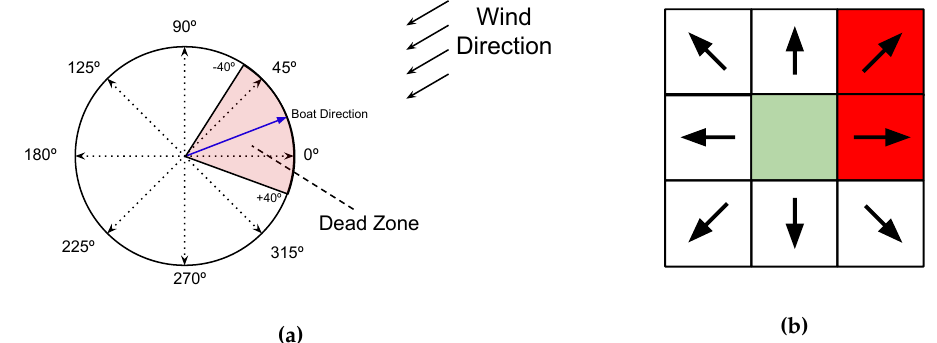
Figure 9. Relationship between the wind direction and the actions not allowed to generate the Q-Table. In ( a ), we show one example where the sailboat desired direction is contrary to the wind. In red color, the dead zone is presented with a range from +40 to − 40 degrees taking account the boat direction.